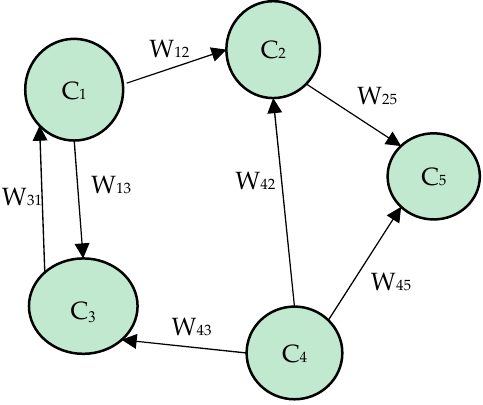
Figure 1. The basic fuzzy cognitive map.